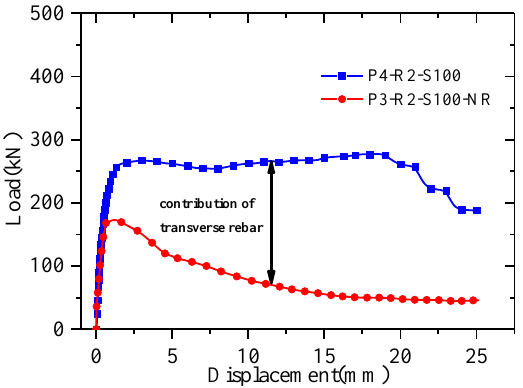
Figure 8. Load–slip curves for the T-type perforated plate connections.